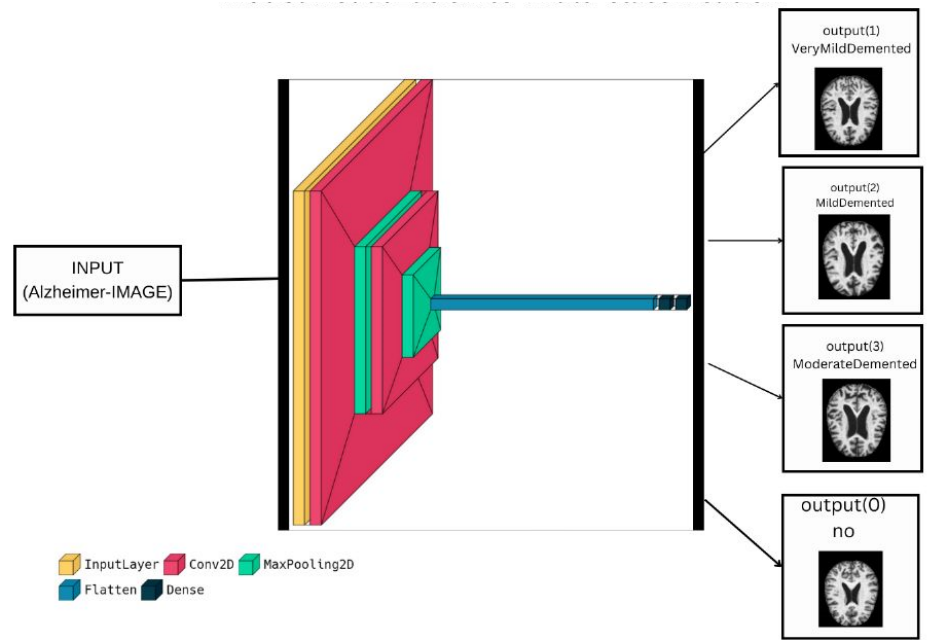
Figure 6. Model visualization to multi-classification task.